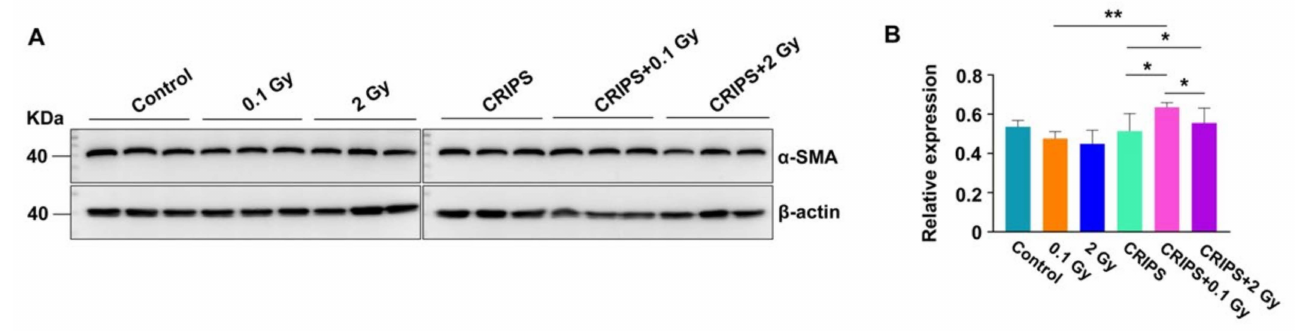
Figure 7. Expression of α -SMA, detected by Western blotting in Trp53 +/ − mouse kidneys. ( A ), the representative images of Western blotting, three replicates in each group; ( B ), the relative expression of α -SMA in each group. CRIPS, chronic restraint-induced stress. * p < 0.05, ** p <